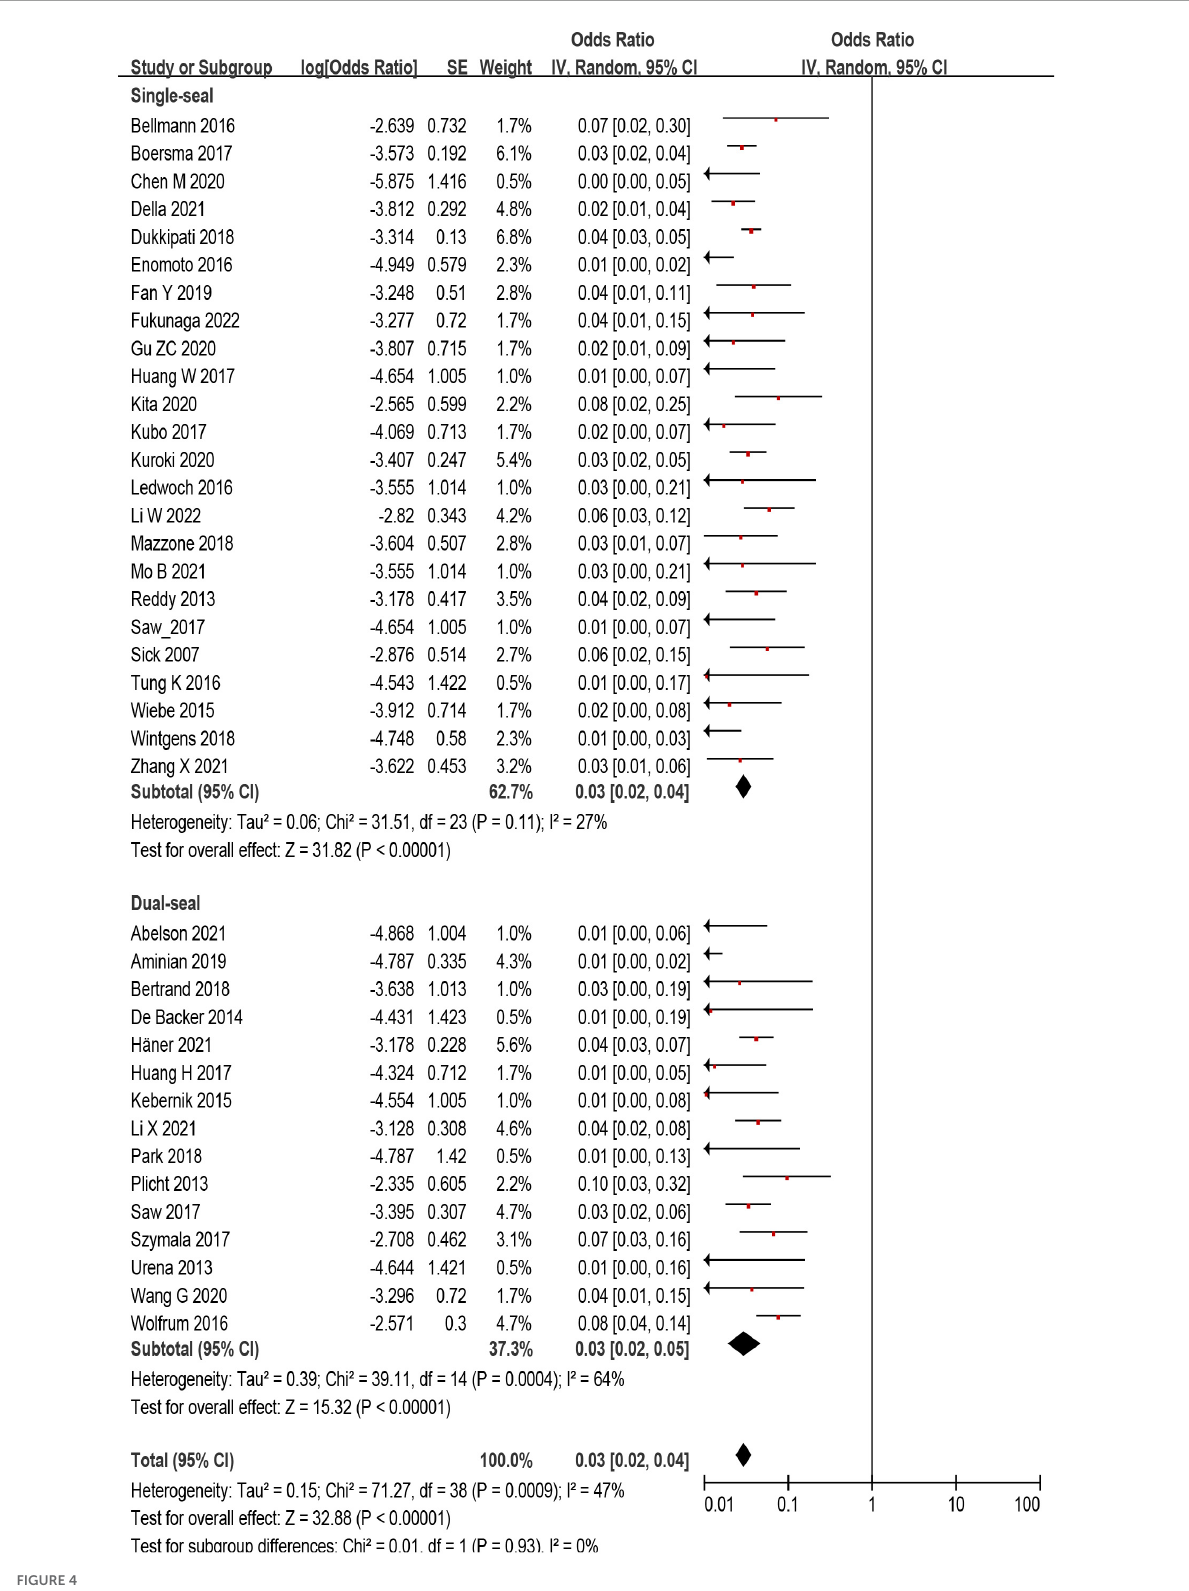
FIGURE4 Forest plot comparing the incidence of device related thrombus (DRT) with subgroup analysis based on occlusion